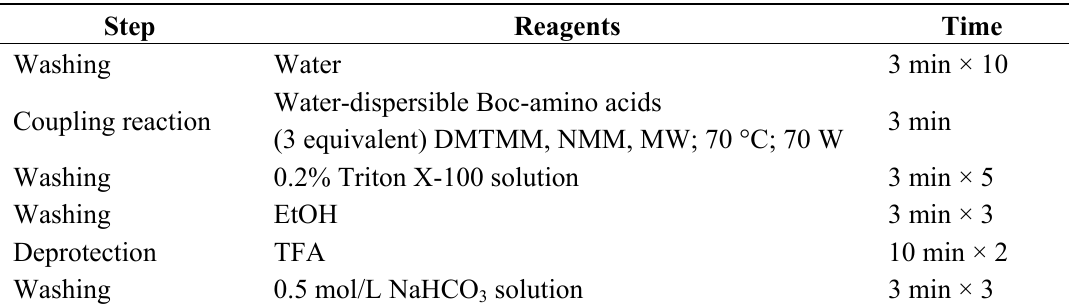
Table 2. Protocol for solid-phase peptide synthesis using a MW assisted coupling reaction in